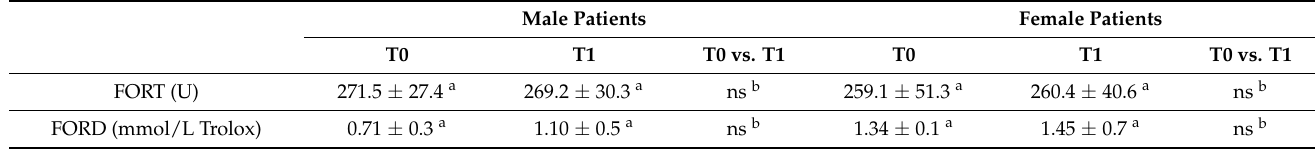
Table 8. Oxidative stress and antioxidant defense mechanism efficiency assessment of the control group.